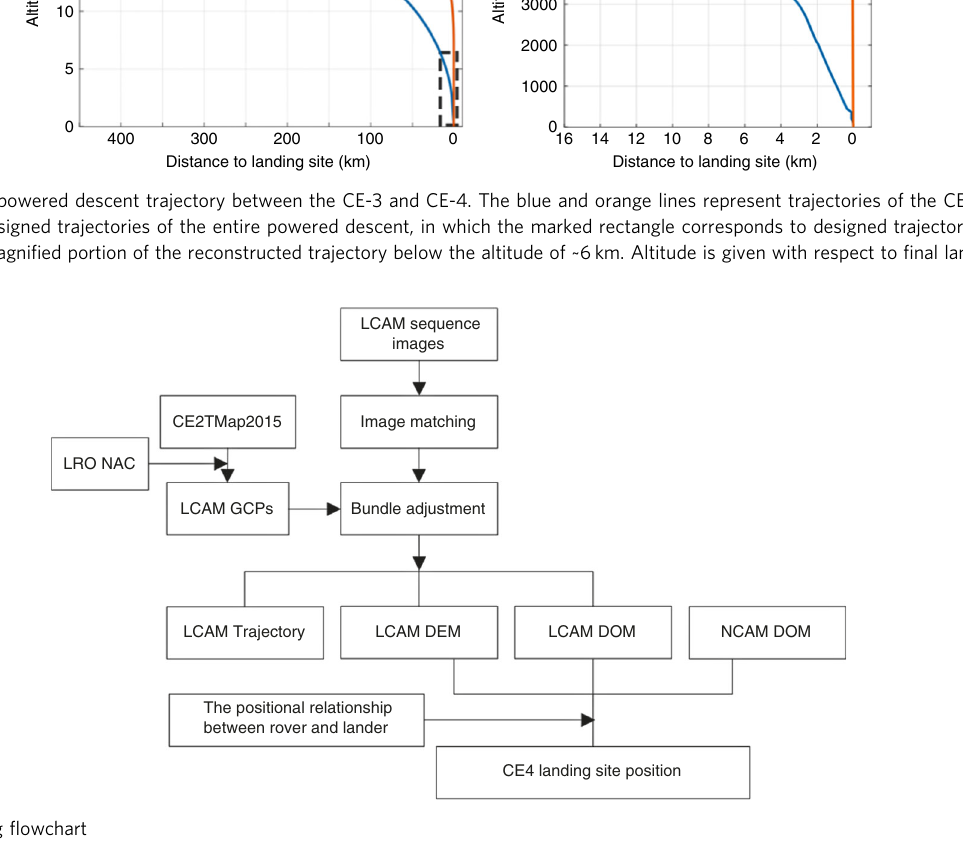
Table 4 Horizontal and vertical deviations of the GCPs for